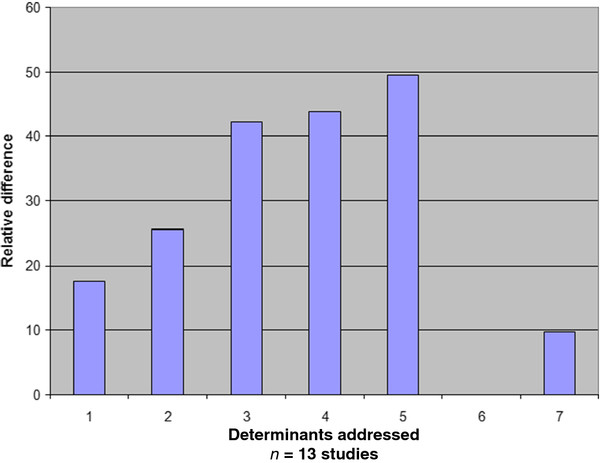
Correlation effectiveness and determinants addressed. Pearson correlation coefficient r = 0.961; p = 0.00.